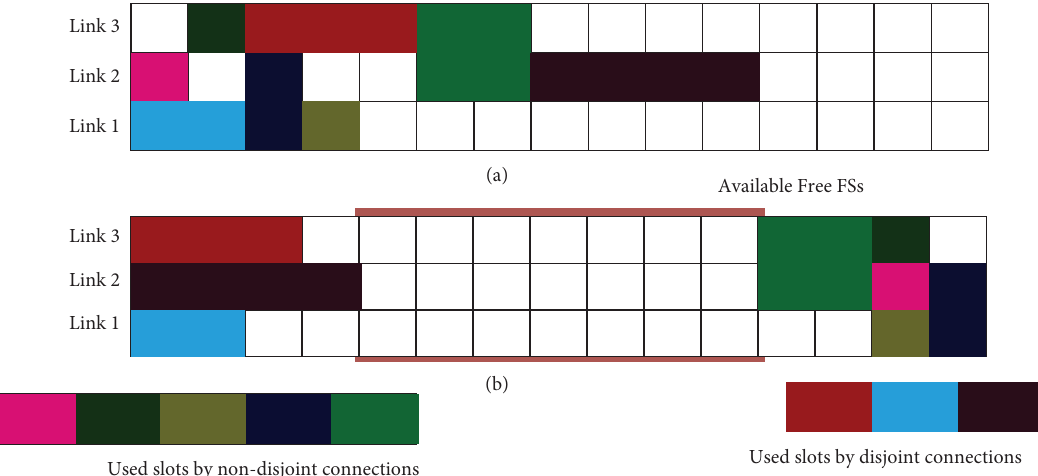
Figure 6: Te frst-last-exact ft spectrum allocation